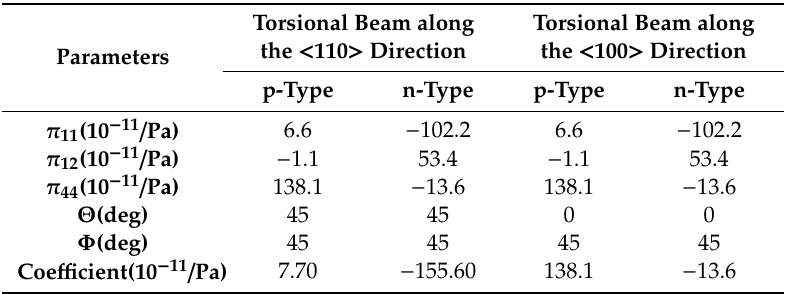
Table 1. The calculated results of the piezoresistive coe ffi Figure 2. Torsional beam and piezoresistive element on silicon(100) wafer.